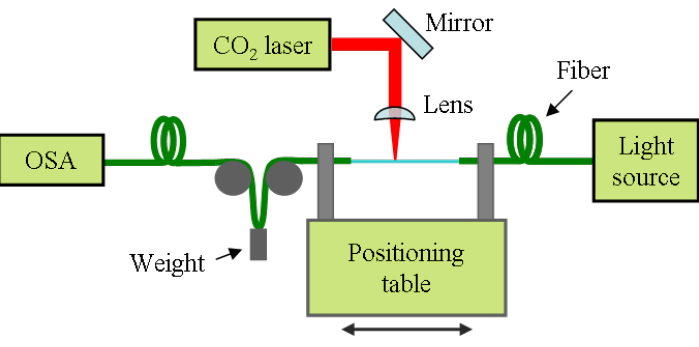
Figure 4. Set-up used to CO